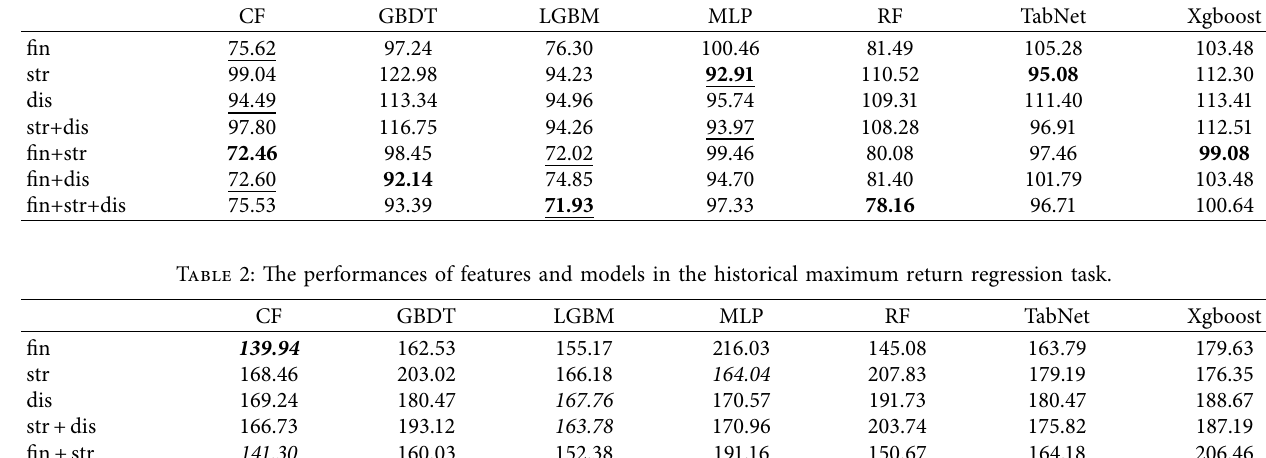
Table 1: Te performances of features and models in the historical average return regression task. CF